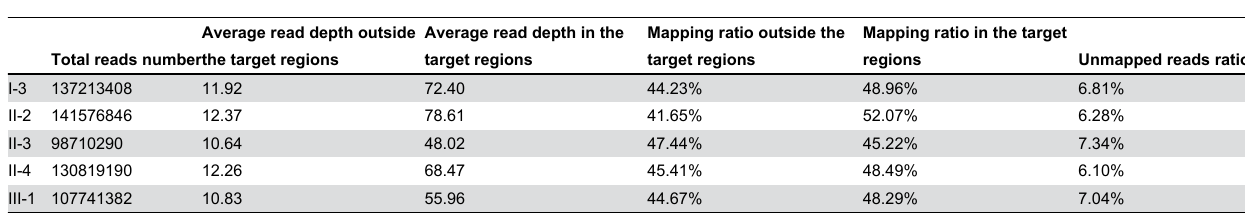
Table 2. Number of reads, variants and variant coverage by sample.